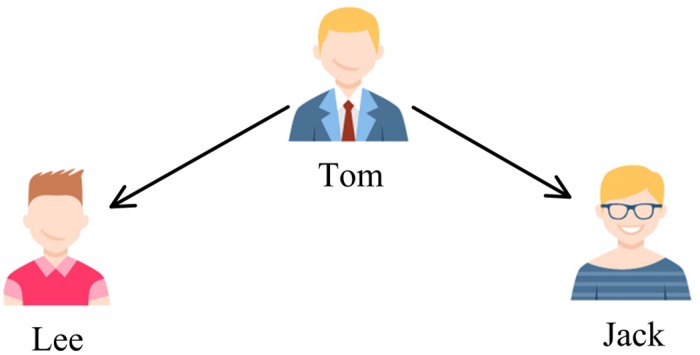
Different relation types in Twitter: The third case.